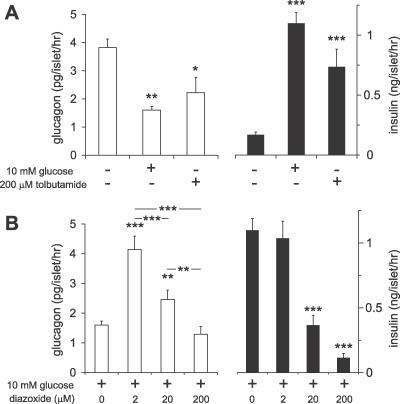
Glucagon Release from Isolated and Intact Human Islets Is Regulated by a KATP Channel-Dependent Pathway(A) Glucagon (open bars) and insulin (filled bars) release was measured from isolated human islets under control conditions and following addition of 10 mM glucose or 200 μM tolbutamide.(B) Glucagon (open bars) and insulin secretion (filled bars) measured in the presence of 10 mM glucose and increasing concentrations of diazoxide (0–200 μM).*, p < 0.05; **, p < 0.01; ***, p < 0.001, compared with controls, unless otherwise indicated.